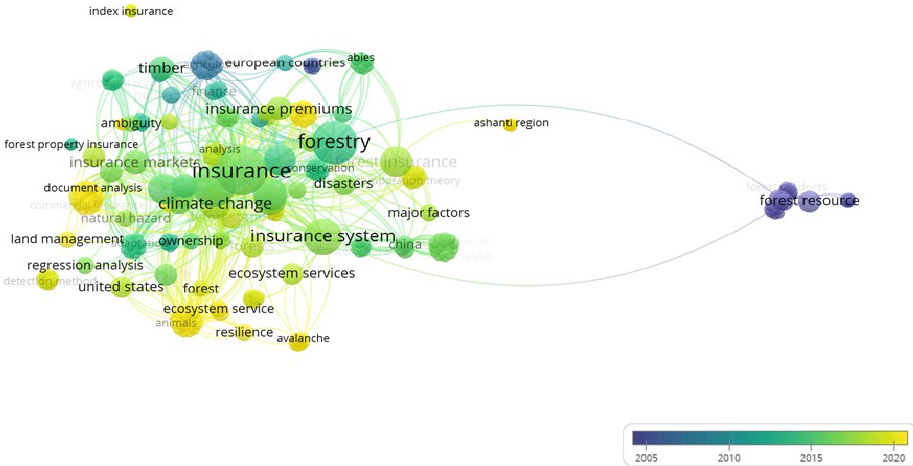
Figure 3. Index keyword co-occurrence network for 30 articles, created with VOSViewer.